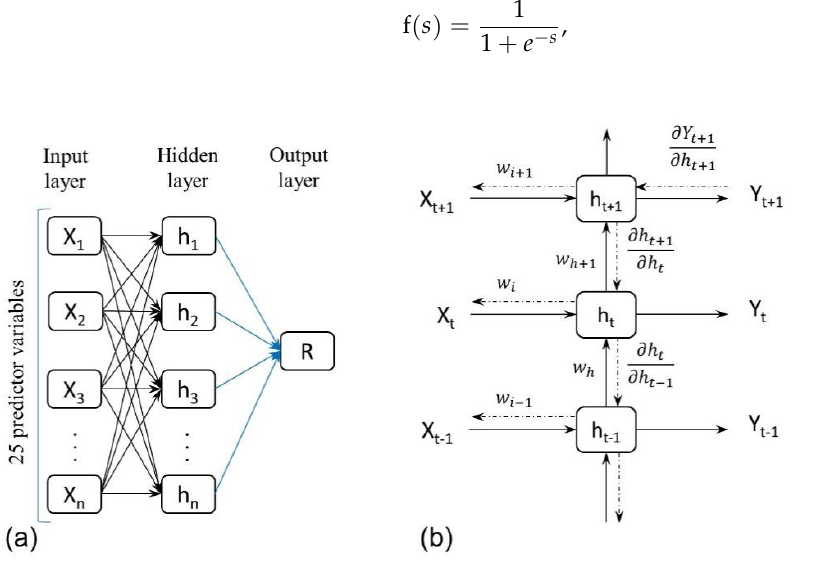
Figure 3. ( a ) Structure of the multi-layer perceptron (MLP) network. ( b ) Structure of the recurrent neural networks (RNN) and scheme of the backpropagation through time (BPTT) algorithm. The solid lines show RNN connections. The dash-dot lines present the BPTT direction.